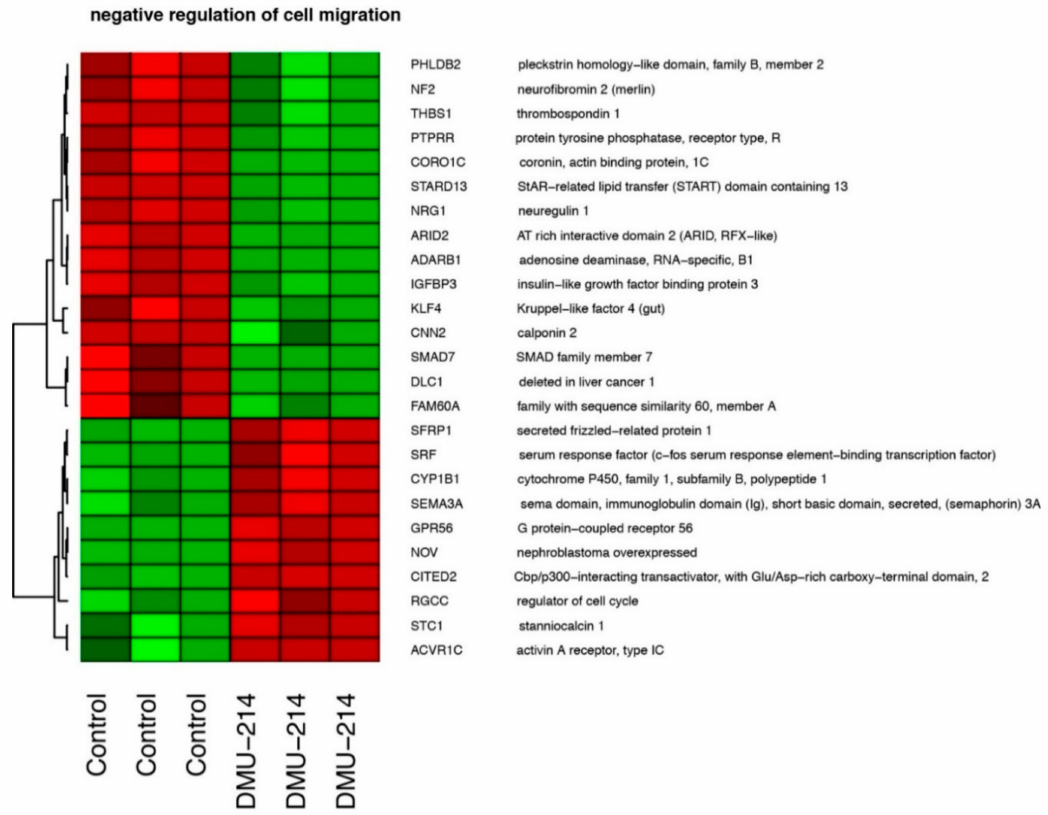
Figure 5. Heat map graph of di ff erentially expressed genes belonging to “negative regulation of cell migration” GO BP term. Arbitrary signal intensity acquired from the microarray analysis is represented by colours (green—higher; red—lower expression in relation to control). Log2 signal intensity values for any single gene were resized to the Row Z-score scale. Gene symbols and gene names of di ff erentially expressed genes were